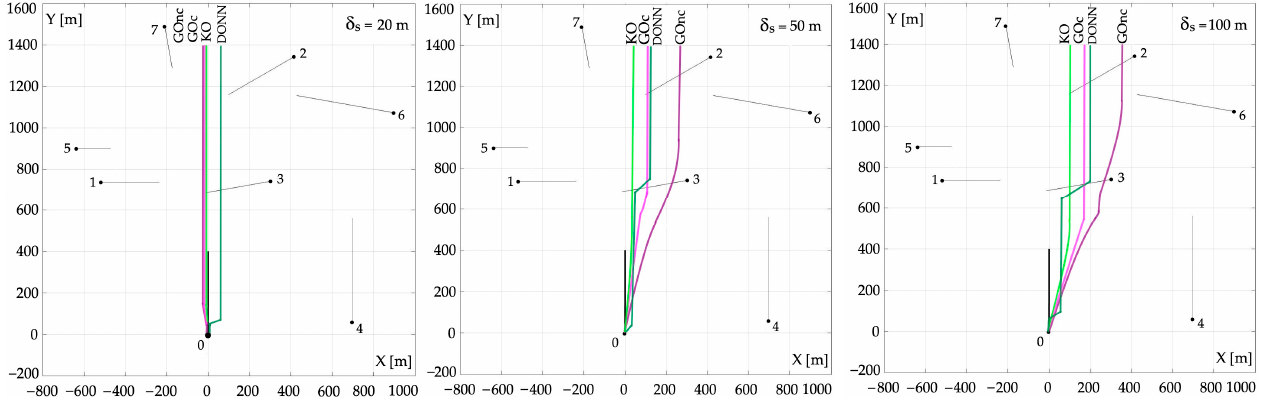
Figure 16. Comparison of the determined trajectories of the autonomous vehicles in multidirectional traffic according to the KO, DONN, and GO algorithms for three safe passing distance values.